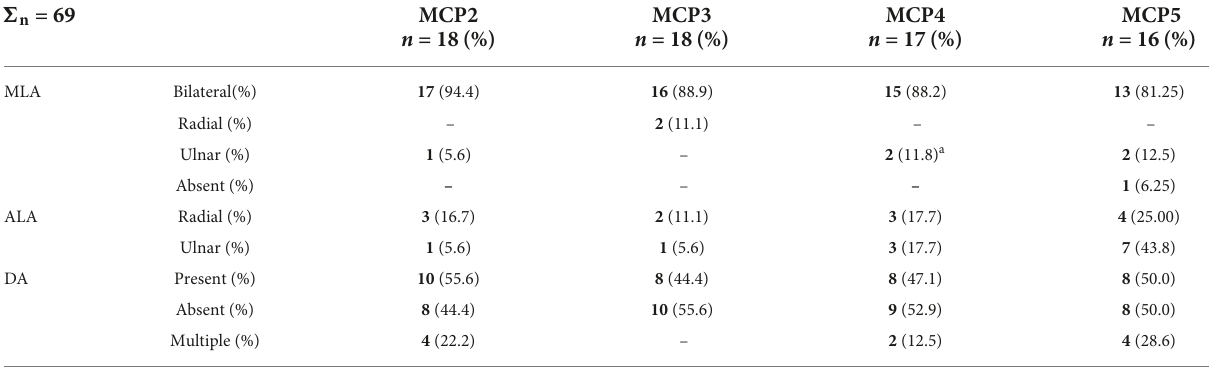
TABLE 3 Occurrence of the main lateral arteries, accessory lateral arteries and dorsal arcade at metacarpophalangeal joints 2–5.